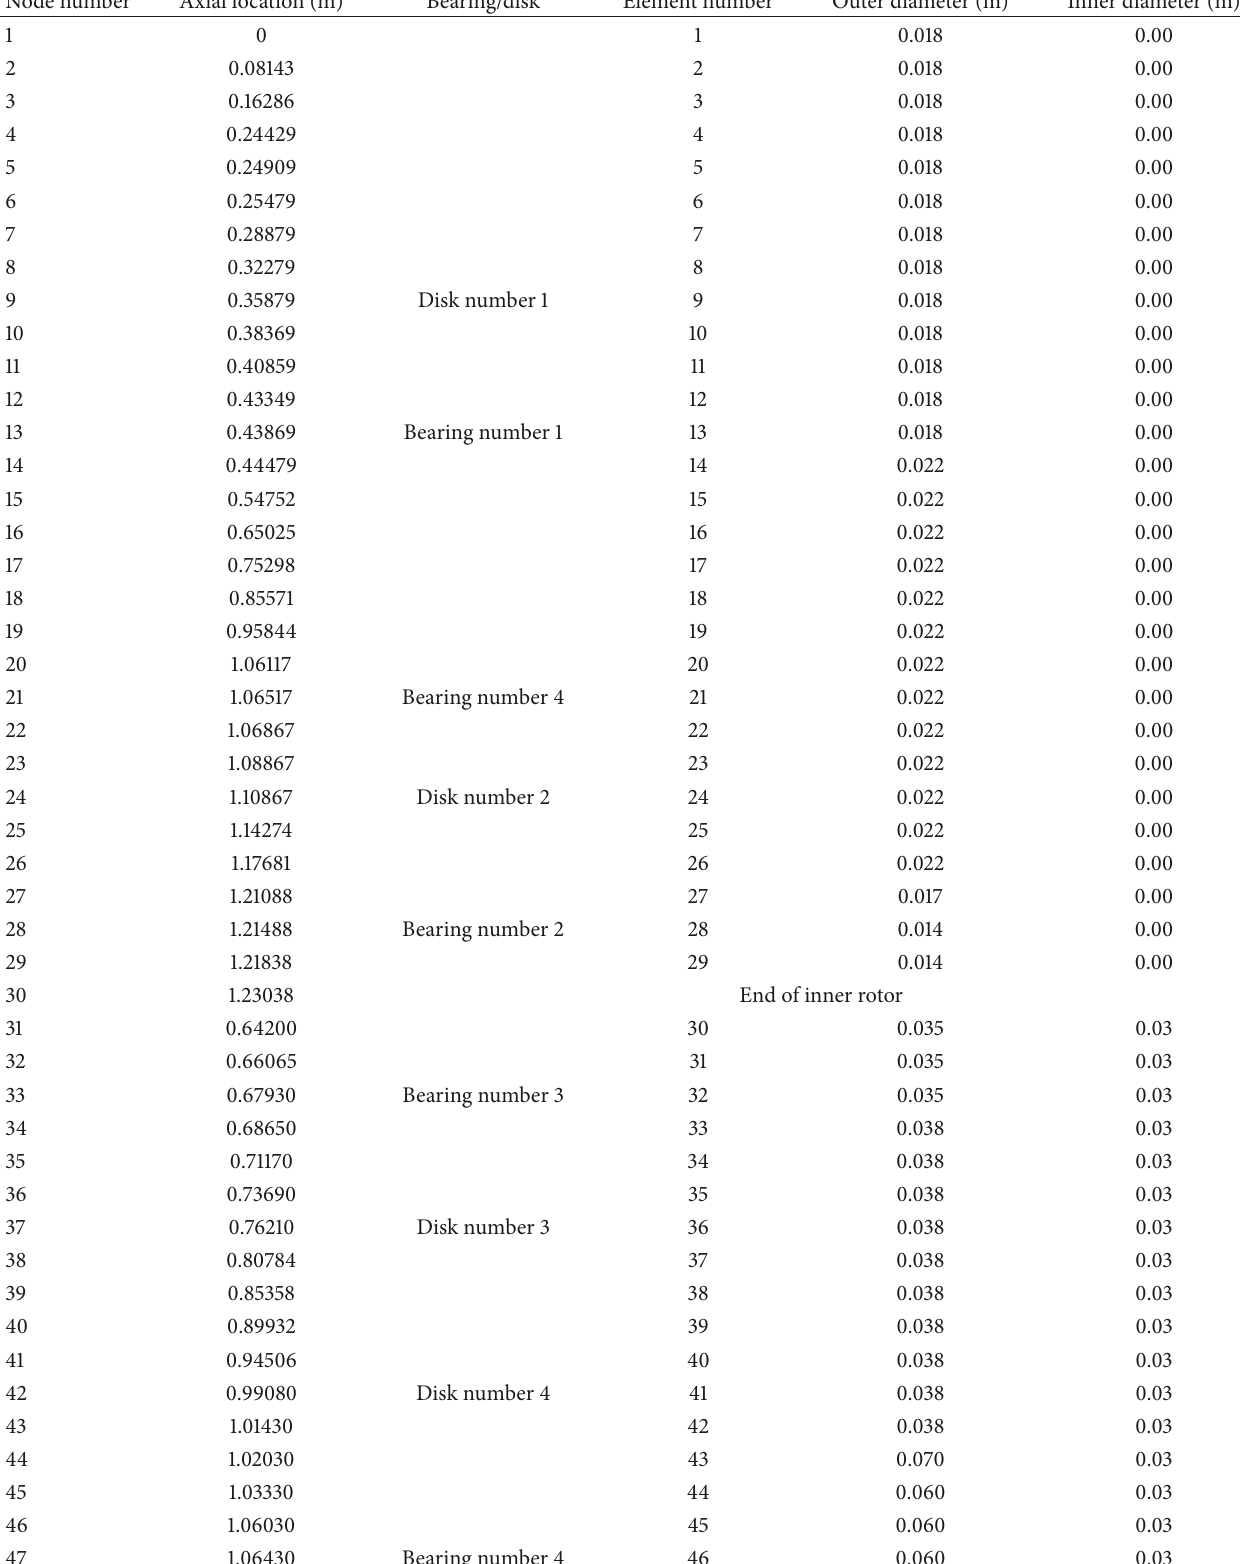
Table 1: Dimension and elements information of the rotor